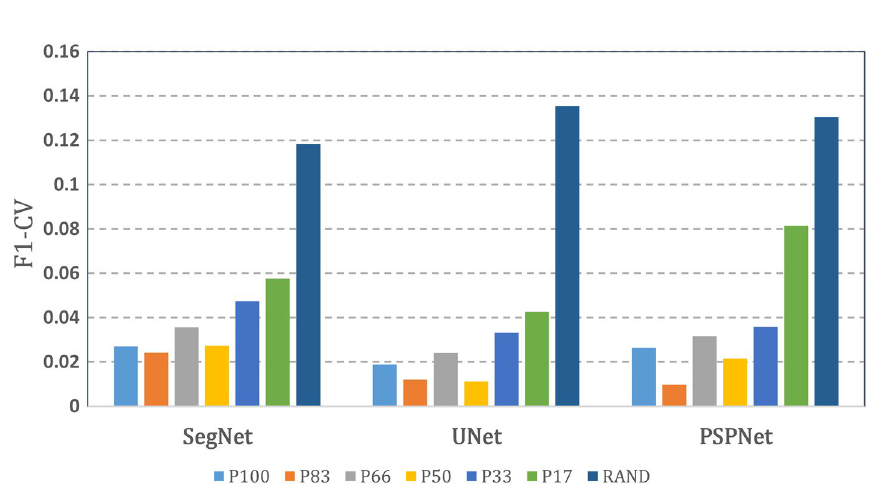
Figure 8. F1-CV values of the seven models obtained by SegNet, UNet, and